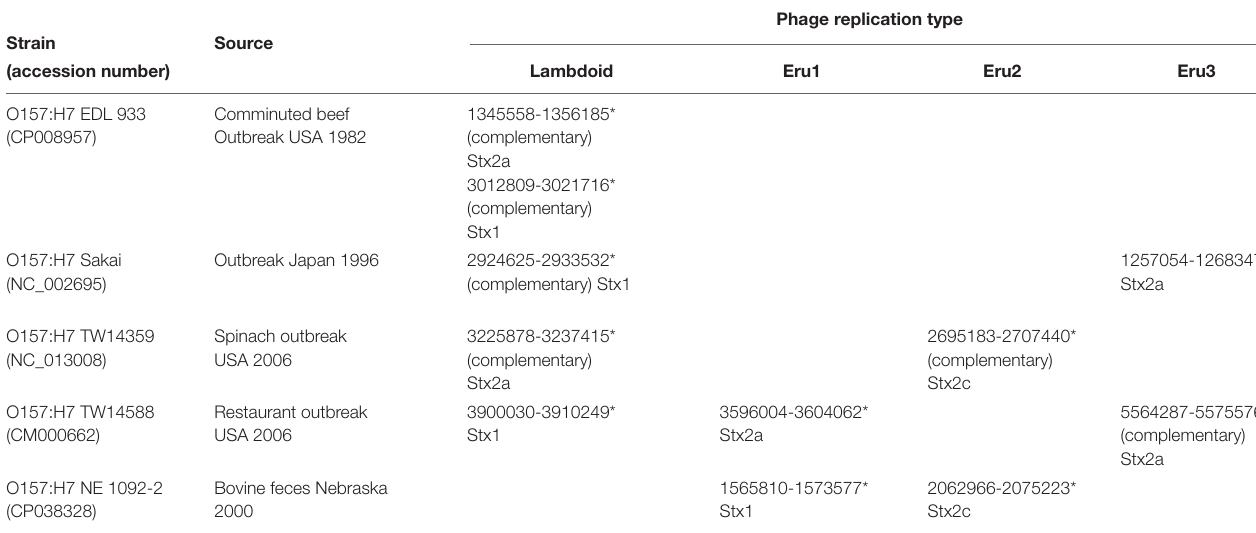
TABLE 3 | Combinations of Stx phages in EHEC/STEC.